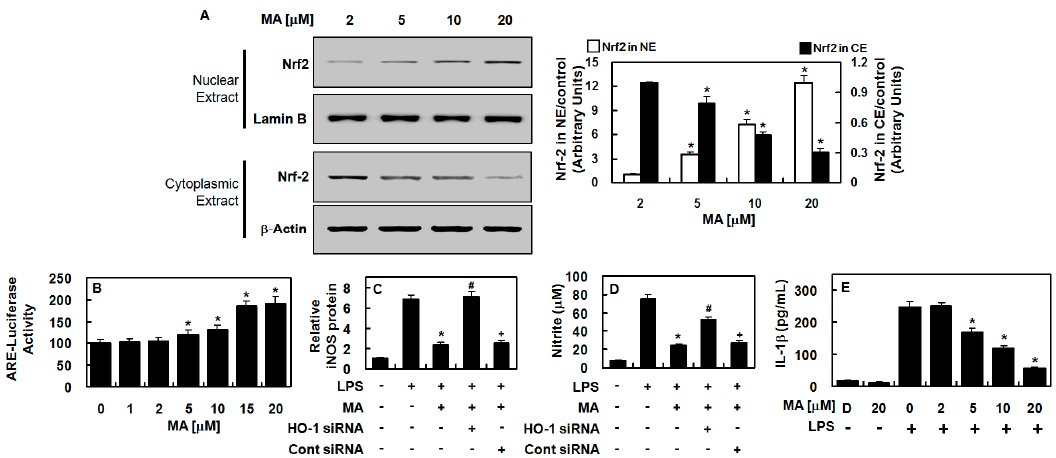
Figure 3. MA induced the nuclear translocation of Nrf2 and anti-inflammatory action in HUVECs. ( A ) HUVECs were harvested, and cytosolic and nuclear fractions were extracted (CE and NE, respectively) after treatment with MA (2–20 µ M) for 6 h. Western blotting was employed with indicated antibodies (Left panel), (Uncropped pictures of the Western blot (upper panel and lower panel) was shown in Figures S2 and S3, respectively), and the densitometric intensity of Nrf2 normalized to Lamin B or β -actin is shown (Right panel). ( B ) ARE luciferase reporter activity was measured with lysates from cells transfected with ARE. ( C,D ) HO-1 expression was suppressed with siRNA to determine whether MA-mediated HO-1 expression was responsible for iNOS ( C ) and NO ( D ) inhibition. ( E ) IL-1 β concentrations were measured with an ELISA kit. The results represent the mean value with SD from three independent experiments conducted in triplicates on three di ff erent days. D denotes 0.2% DMSO treatment, which was used as the vehicle control. * p < 0.05 versus LPS, # p < 0.05 versus LPS + MA, or + p < 0.05 versus LPS + MA + HO-1 siRNA.